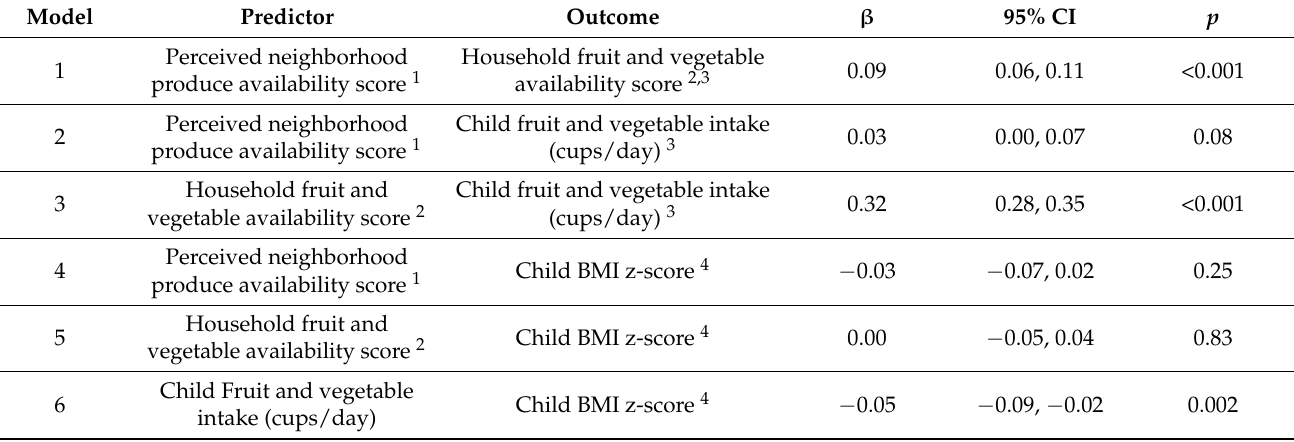
Table 2. Associations between perceived neighborhood produce availability and household fruit and vegetable availability, child fruit and vegetable intake, and child body mass index z-score (BMI z-score) in the Healthy Communities Study (N =